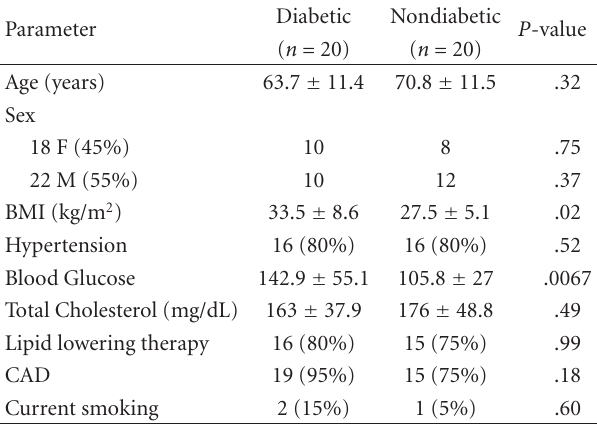
Table 2: The clinical characteristics of the 40 enrolled